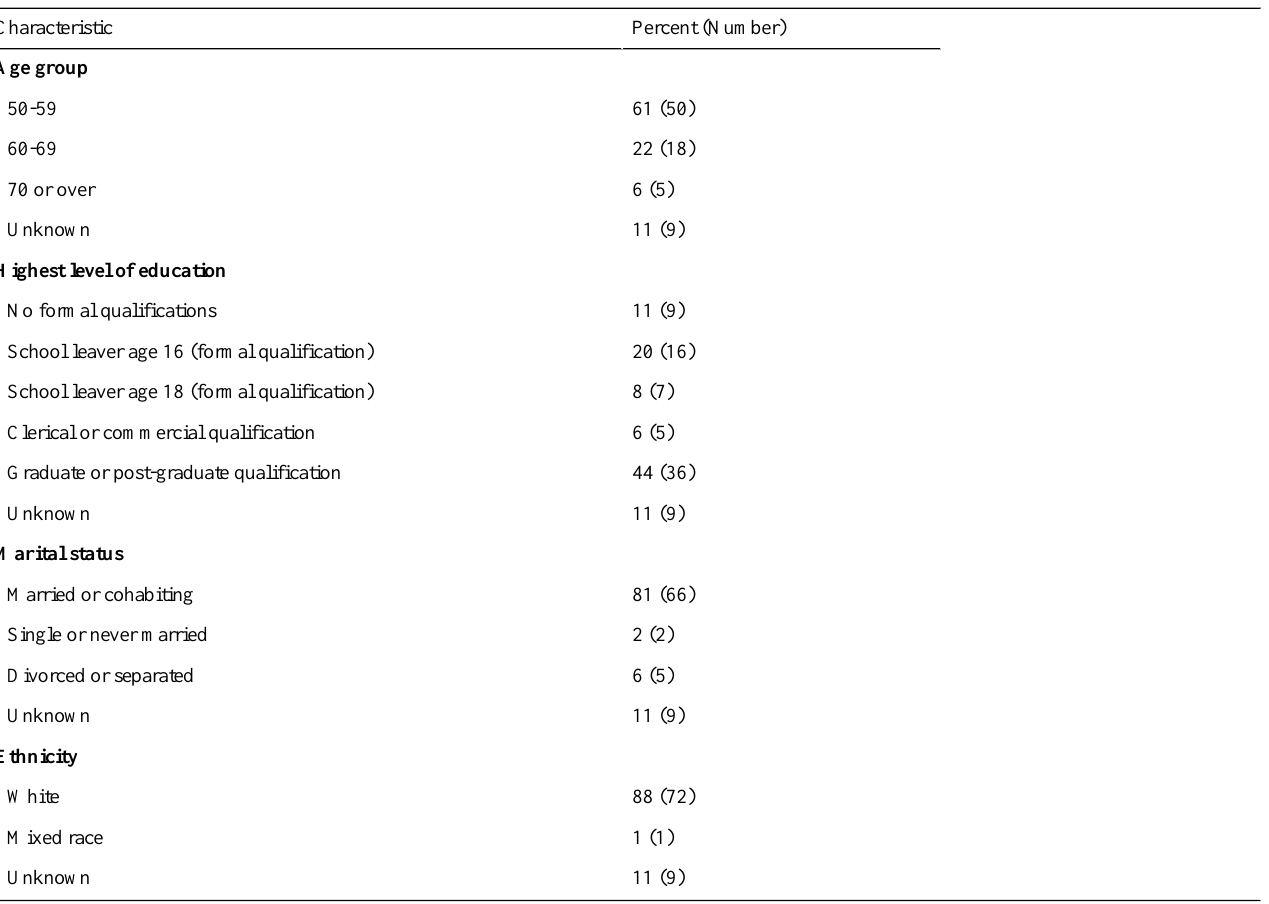
Table 1. Participants’characteristics (n =